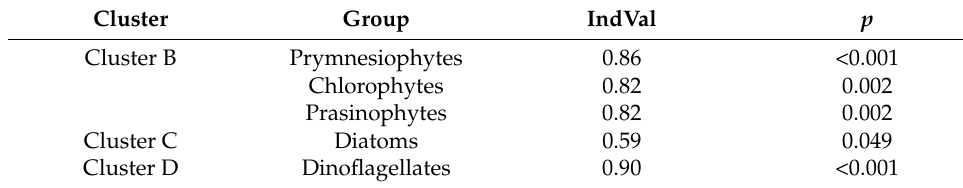
Table 2. Results of the indicator species analysis for the SOM clusters.